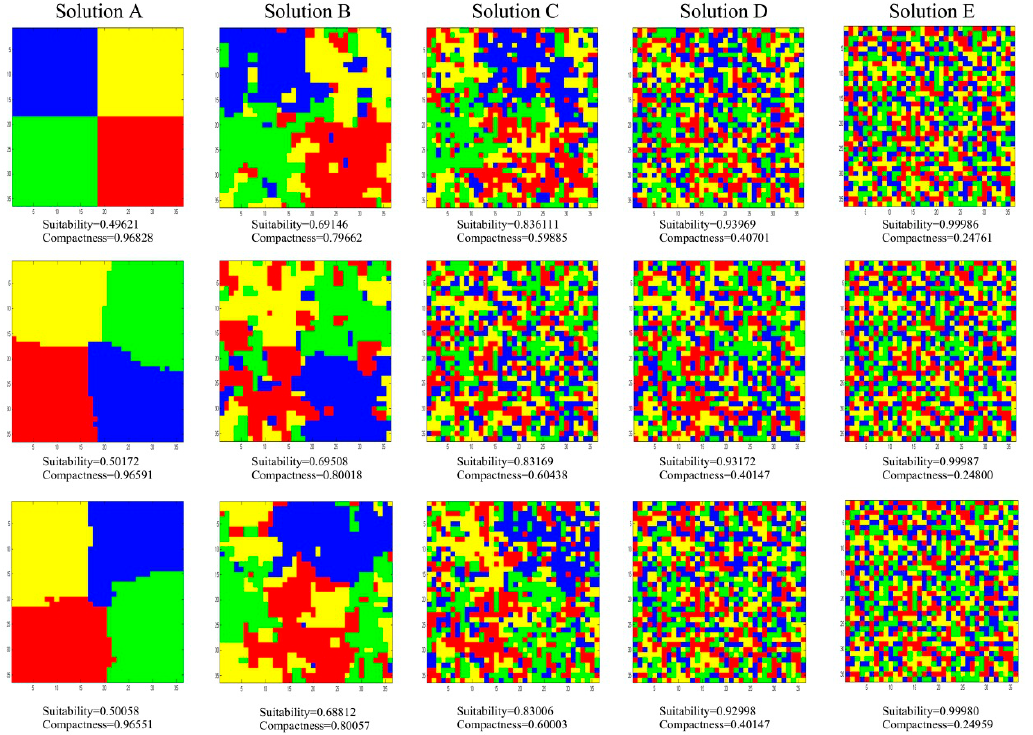
Figure 8. Corresponding spatial patterns of solutions in three random selected Pareto fronts with their approximate positions labeled in Figure 7.